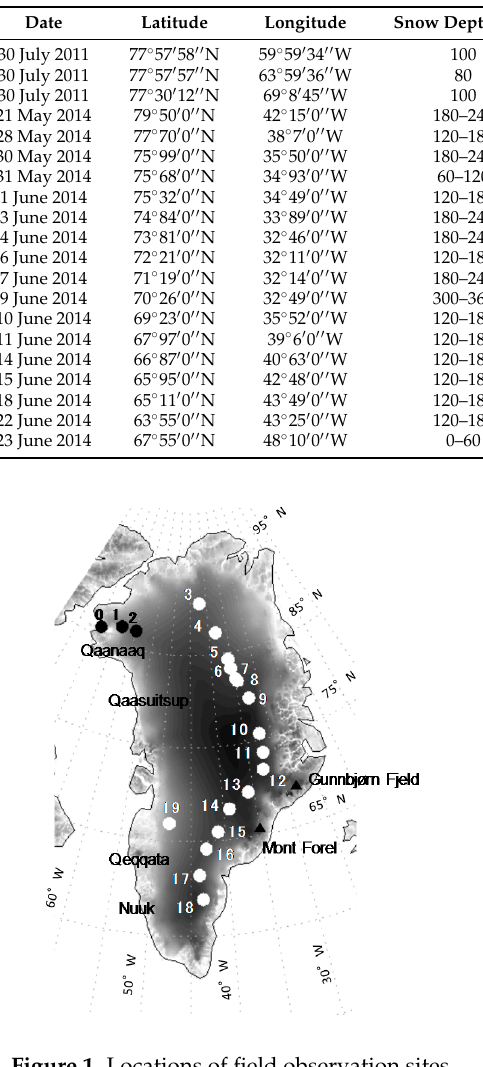
Figure 1. Locations of field observation sites.